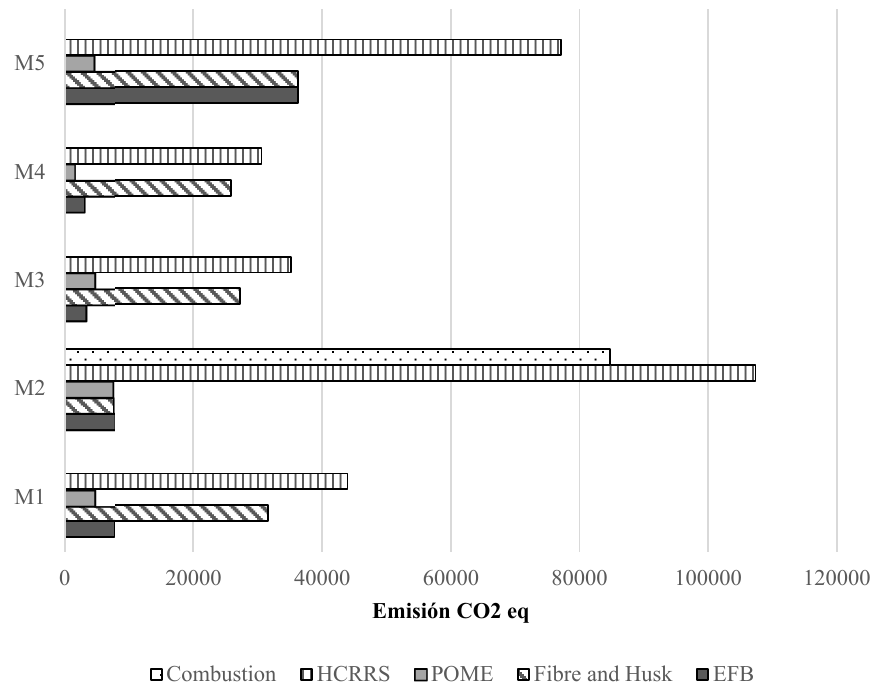
Figure 7. Estimation of the HCRRS indicator: CO 2eq emissions of the moments diagnosed by the RRSFM indicator.